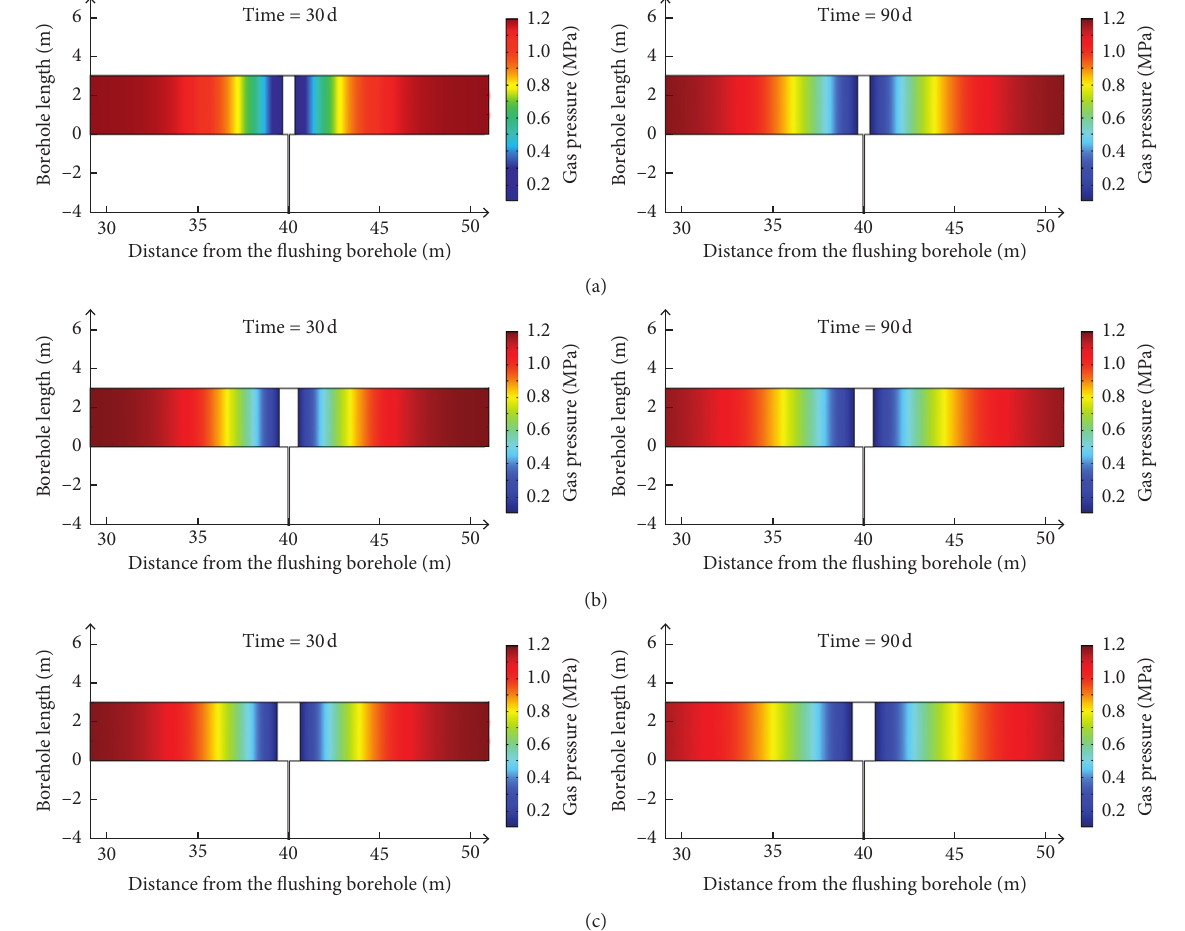
Figure 11: Cloud map of gas pressure distribution on the 30 th and 90 th day with different coal outputs. (a) Coal outputs � 0.5t/m, (b) coal outputs � 1.0t/m, and (c) coal outputs �